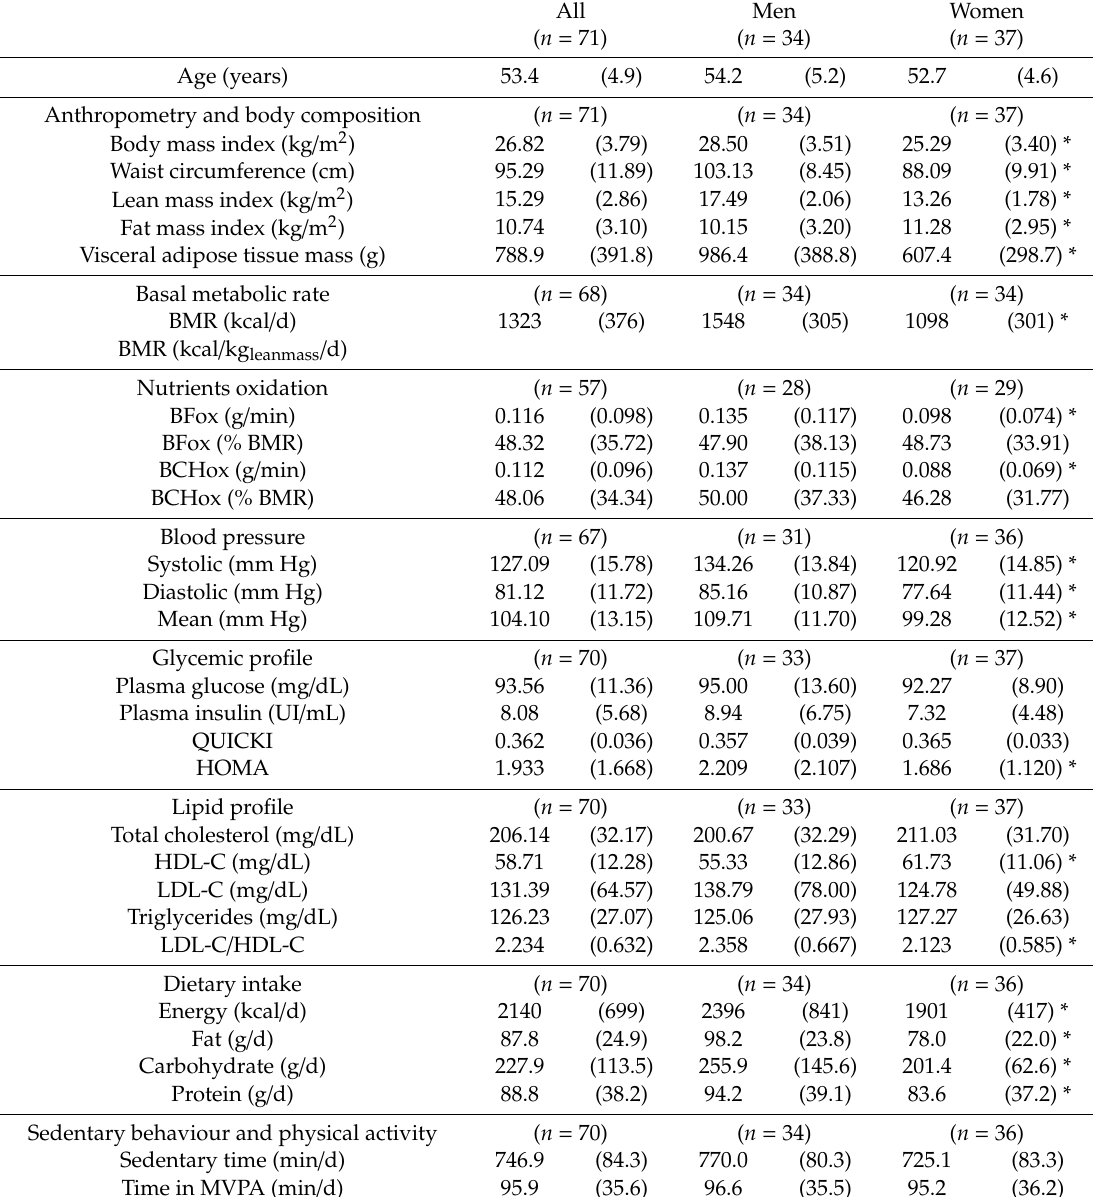
Table 1. Descriptive characteristics of the study